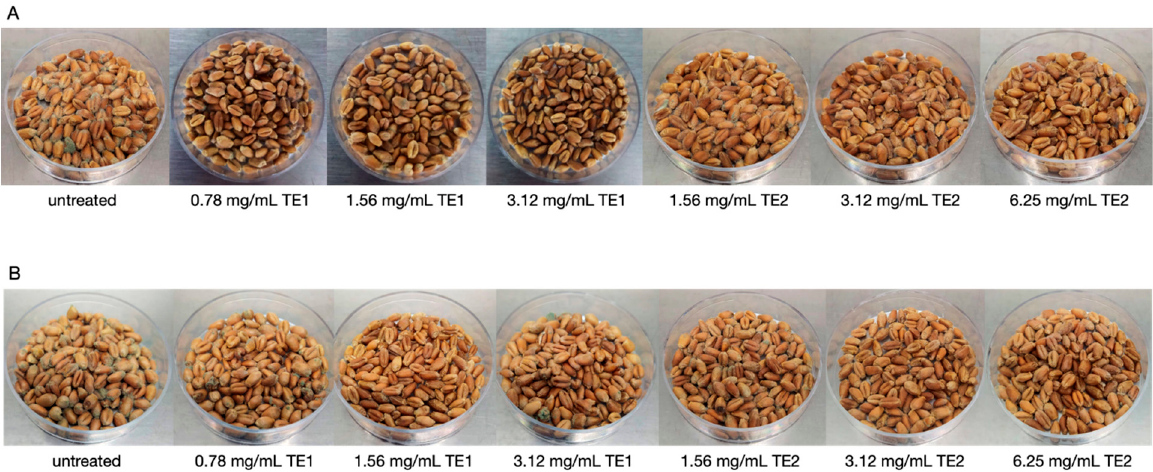
Figure 5. Growth of Penicillium verrucosum on wheat treated with TE1, TE2 and untreated, at ( A ) 10 days and ( B ) 20 days incubation.